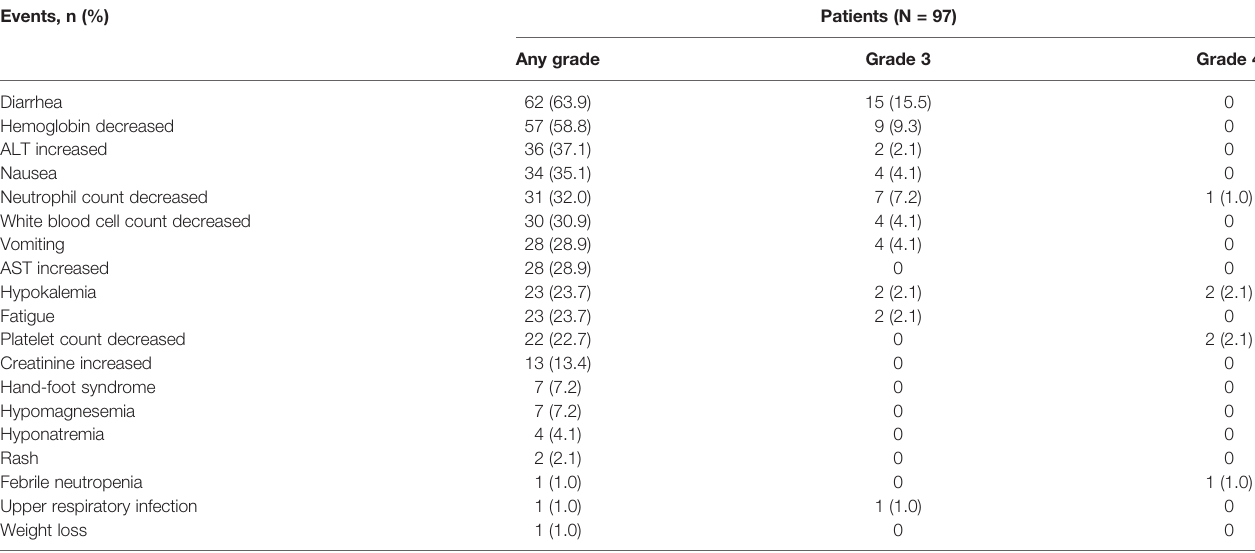
TABLE 4 | Treatment-related adverse events before